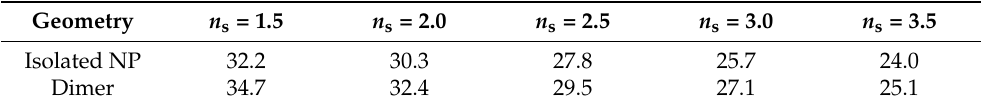
Table 1. Fraction of radiation that is scattered into the substrate, f subs , integrated over the analyzed spectral range ( λ ∈ [800–1500] nm) for different substrate refractive indices, n s .